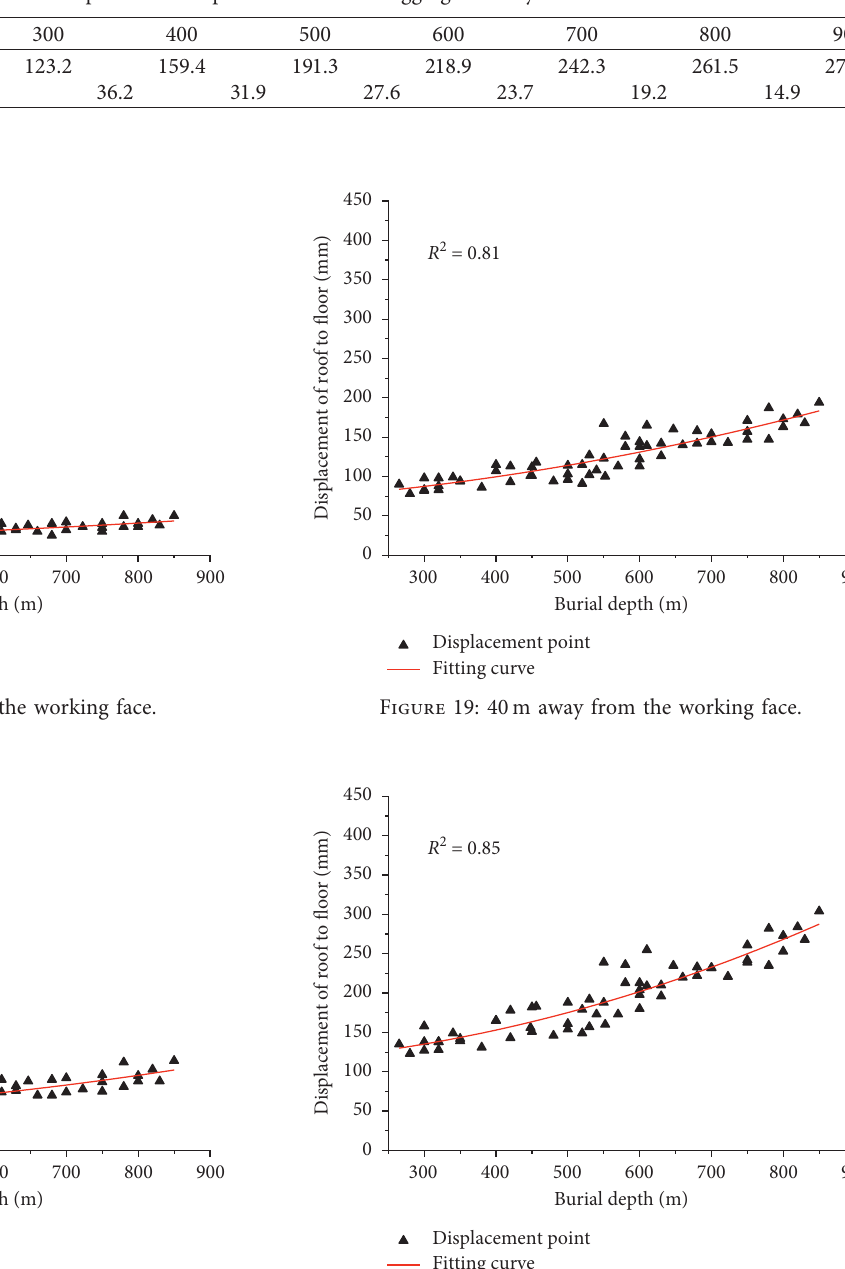
Table 2: Comparison of displacement of new digging roadway ribs.